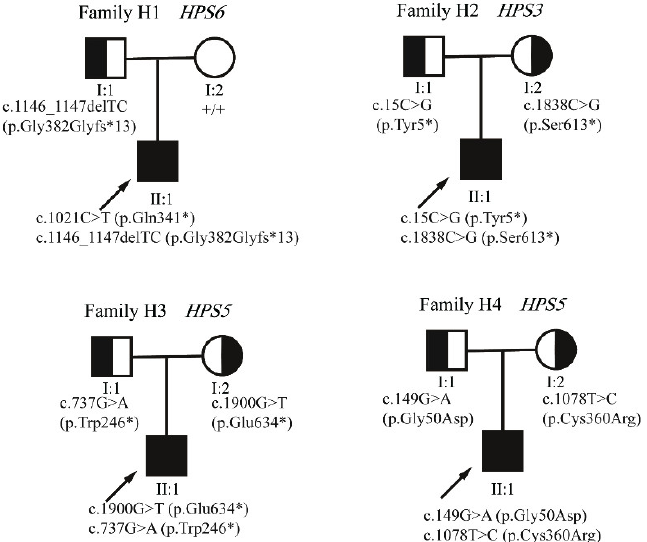
Figure 2. Schematic pedigrees of the families with causative HPS-associated gene mutations. Ar- rows indicate proband; filled symbols indicate compound heterozygous; Half-filled areas indicate heterozygous and unfilled indicate unaffected individuals. Table 3. Causative mutations identified in the HPS patients.